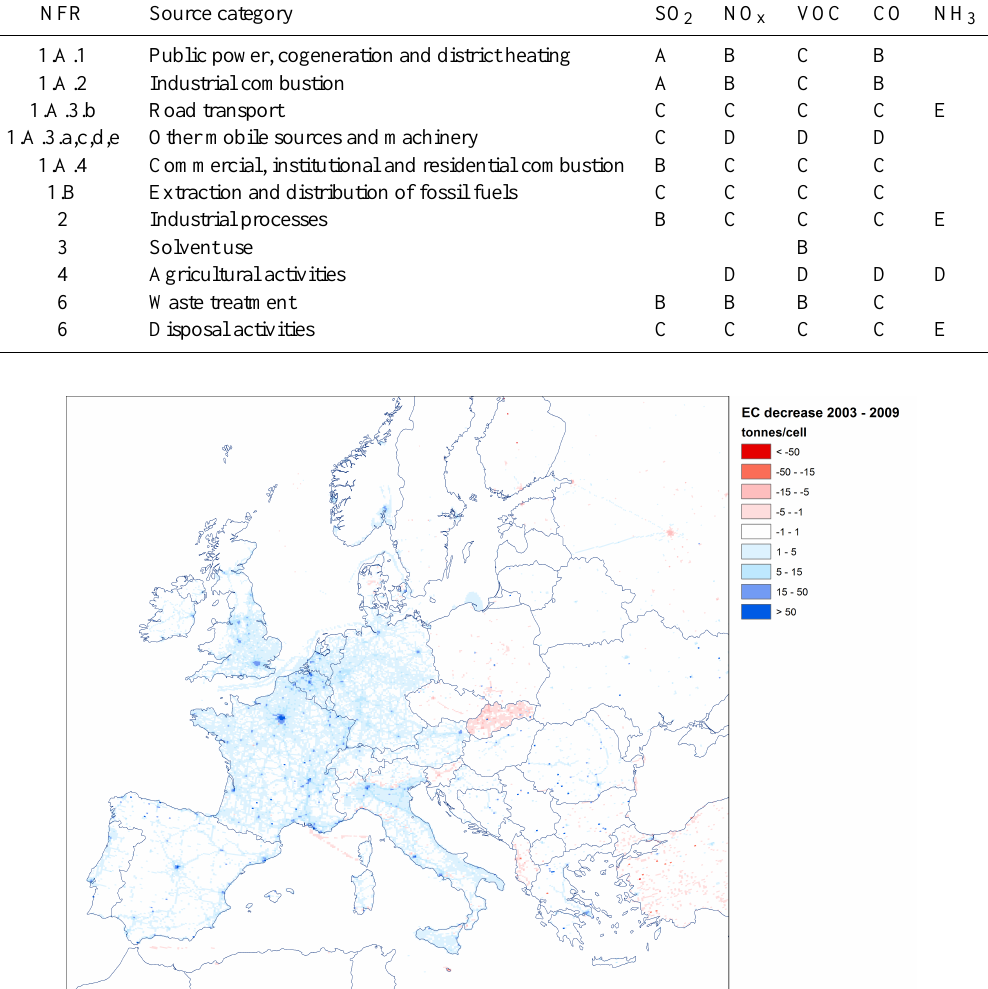
Figure 11. Change in EC (<2.5µm) emissions between 2003 and 2009 in Europe, for all